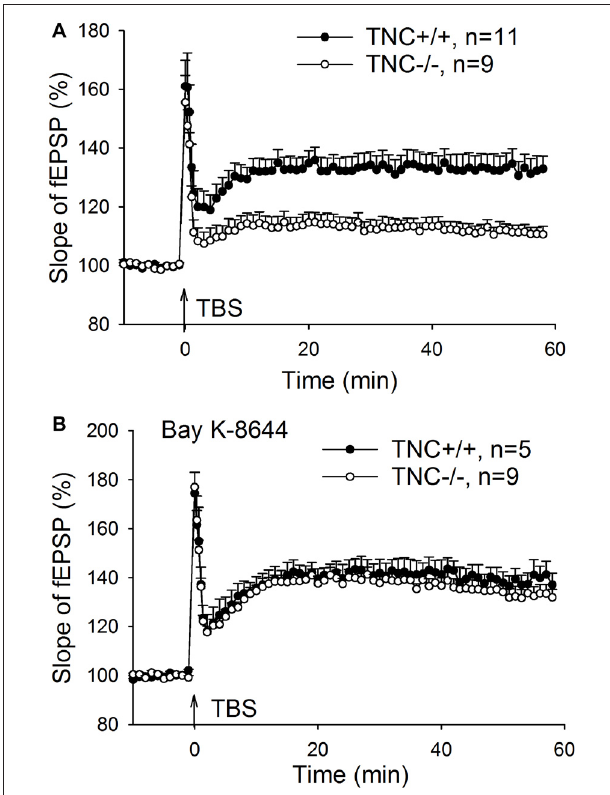
FIGURE 2 | Immunoreactivity for Ca v 1.2 and Ca v 1.3 subunits of neuronal L-VGCCs in the CA1 areas of TNC + / + and TNC − / − mice. The strongest signal was observed in somata and apical dendrites of cells located in the stratum pyramidale . There was no obvious difference in expression between genotypes, although a slight increase in the expression of Ca v 1.3 in TNC − / − mice was noticed by comparing images from three pairs of wild-type and knockout mice. Scale bar: 200 µ m, applicable to all